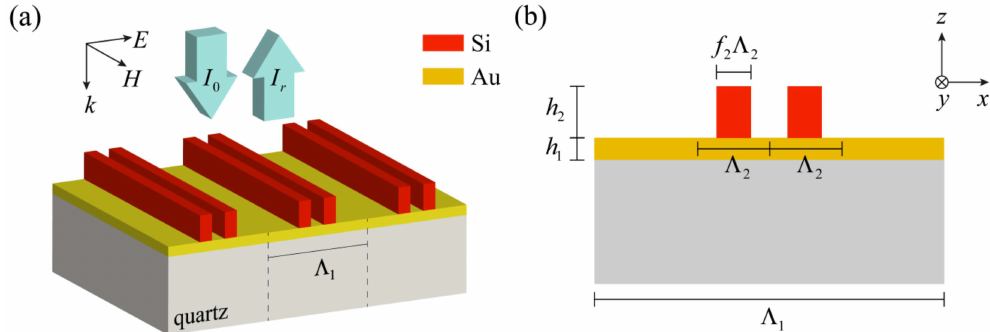
Figure 1. ( a ) Schematic view of the narrowband perfect absorber (PA). I 0 and I r stand for the intensities of the incidence and reflection. Λ 1 stands for the structure period. ( b ) Cross-sectional view of the unit